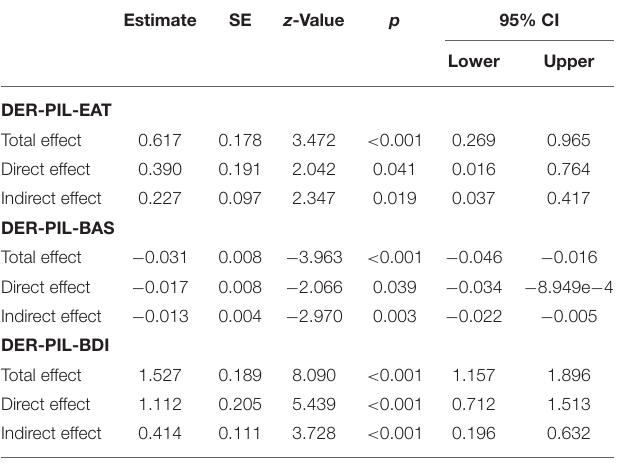
TABLE 3 | Multiple mediation model of meaning in life between emotional dysregulation and the psychopathology of eating disorders in young adult women without eating disorders.